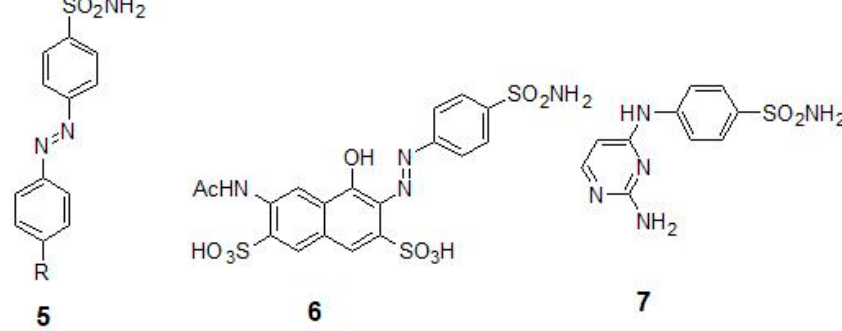
Figure 3. Chemical structures of diazenylbenzenesulfonamides ( 5 ), prontosil ( 6 ) and 2-amino- pyrimidin-4-yl-sulfanilamide ( 7 ).